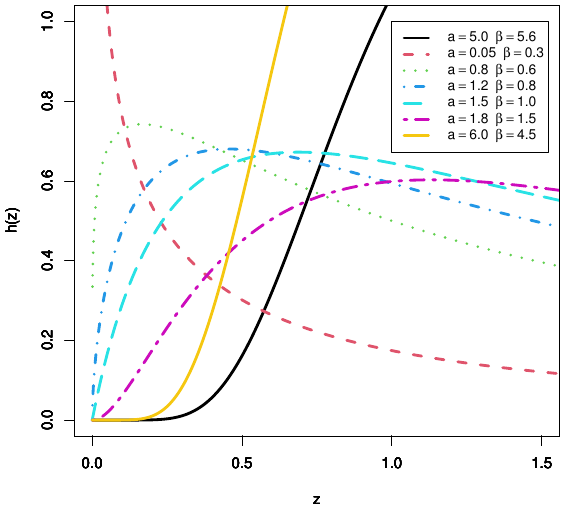
Figure 2. HRF for the TCP-ITL